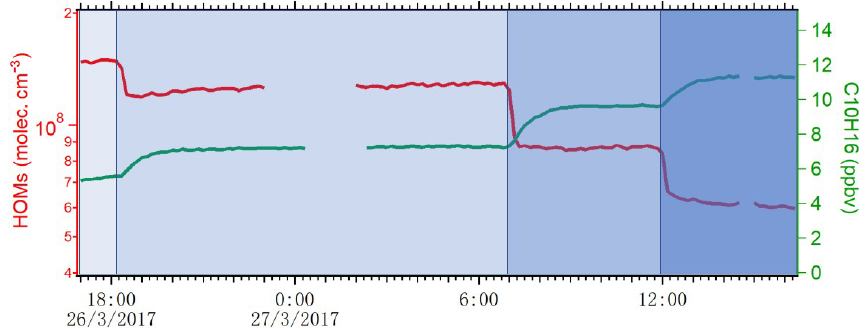
Figure 2. The variation in total HOM concentration and alpha-pinene during four experiments where the 400nm lights were decreased stepwise from seven lights to four lights, two lights and one light.